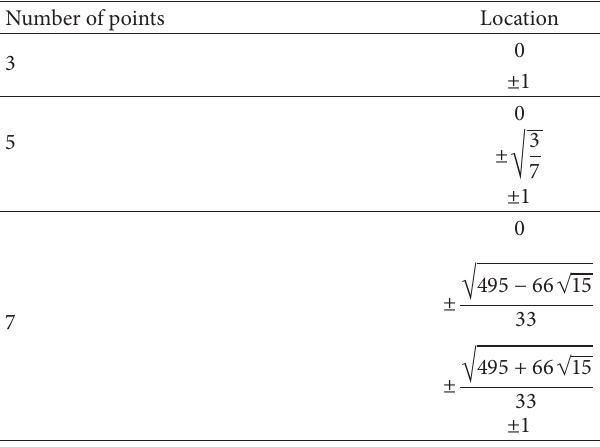
[ A ] −1 b . The values of the states located at collocation points are